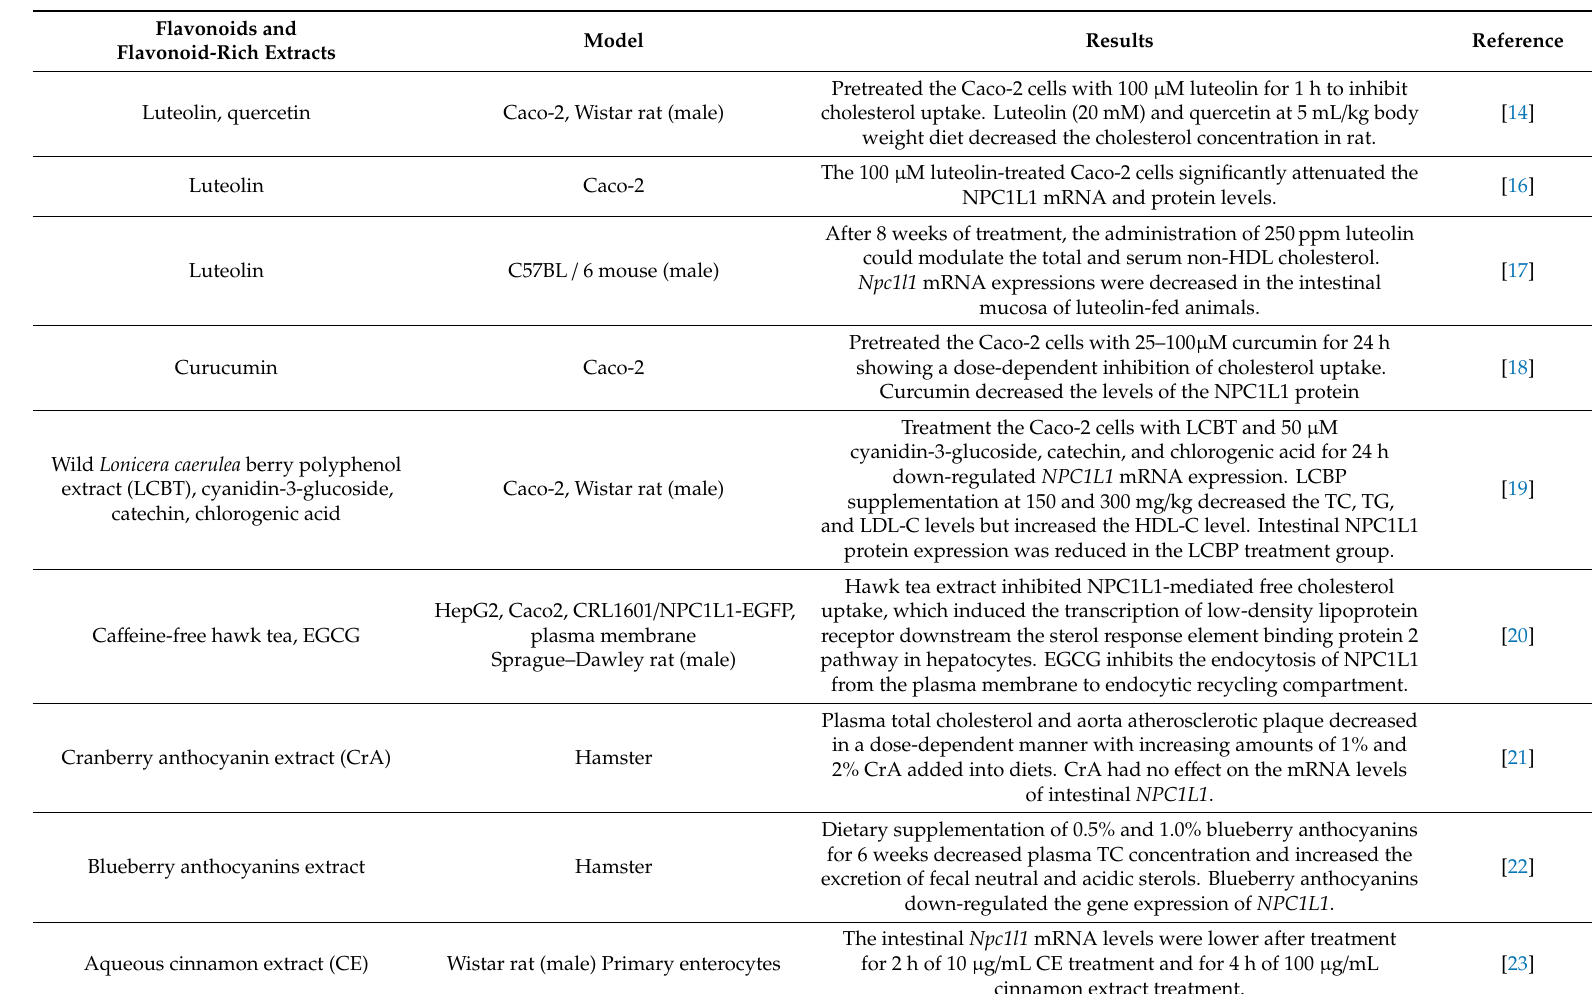
Table 1. Flavonoids and flavonoid-rich extracts e ff ect on